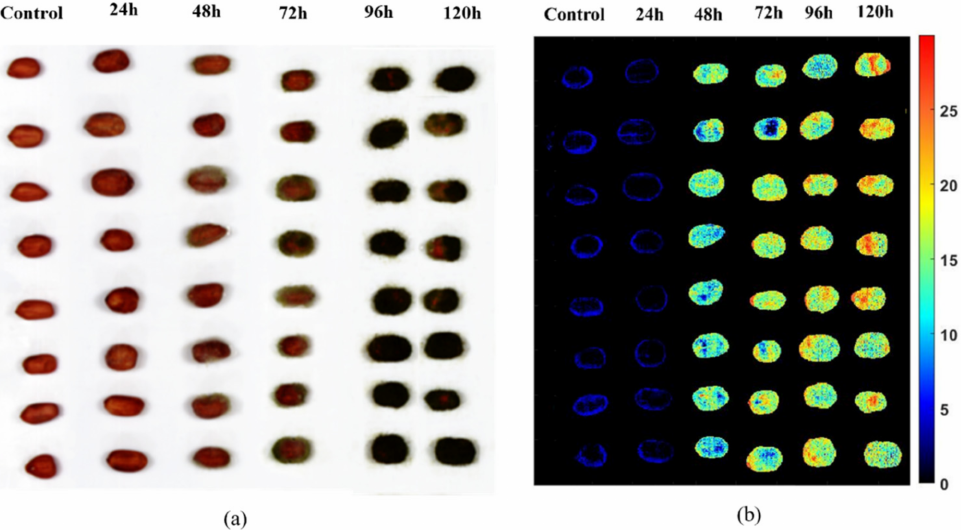
Figure 5. Photograph ( a ) and visualization map of predicted AFB 1 concentrations ( b ) of peanut